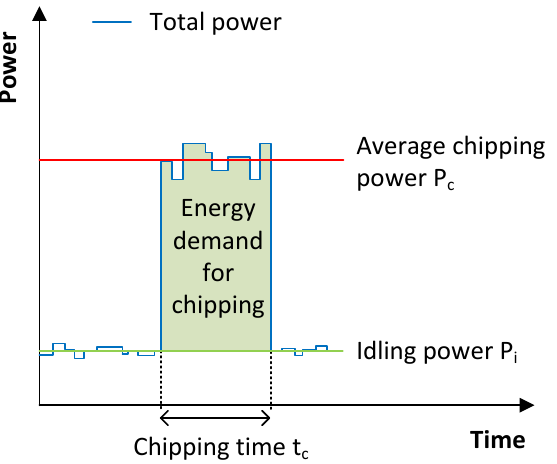
Figure 5. Determining the mean energy demand for comminution of wood in a drum chipper, taking idling power into account (P c average chipping power; P i Idling power; t c chipping